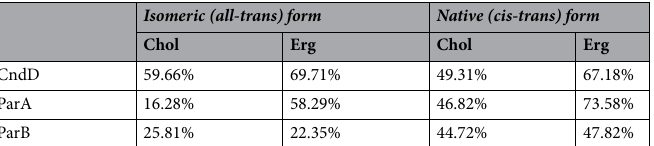
Table 1. Percentage values of the simulation time while the side chain was embedded in an opposite leaflet of a given system (calculated for the dissociated antibiotic/sterol complexes).